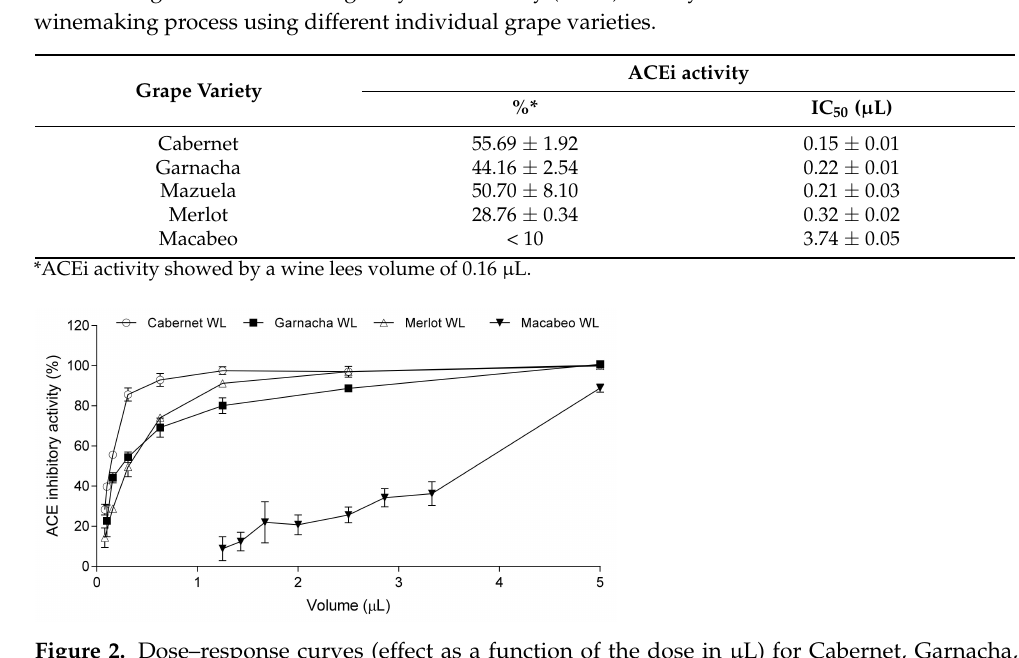
Figure 2. Dose–response curves (effect as a function of the dose in µ L) for Cabernet, Garnacha, Merlot, and Macabeo wine lees (WL). Values are the average of three replicates ±